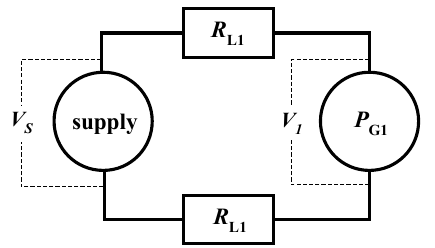
Figure 1. Equivalent circuit of one node.